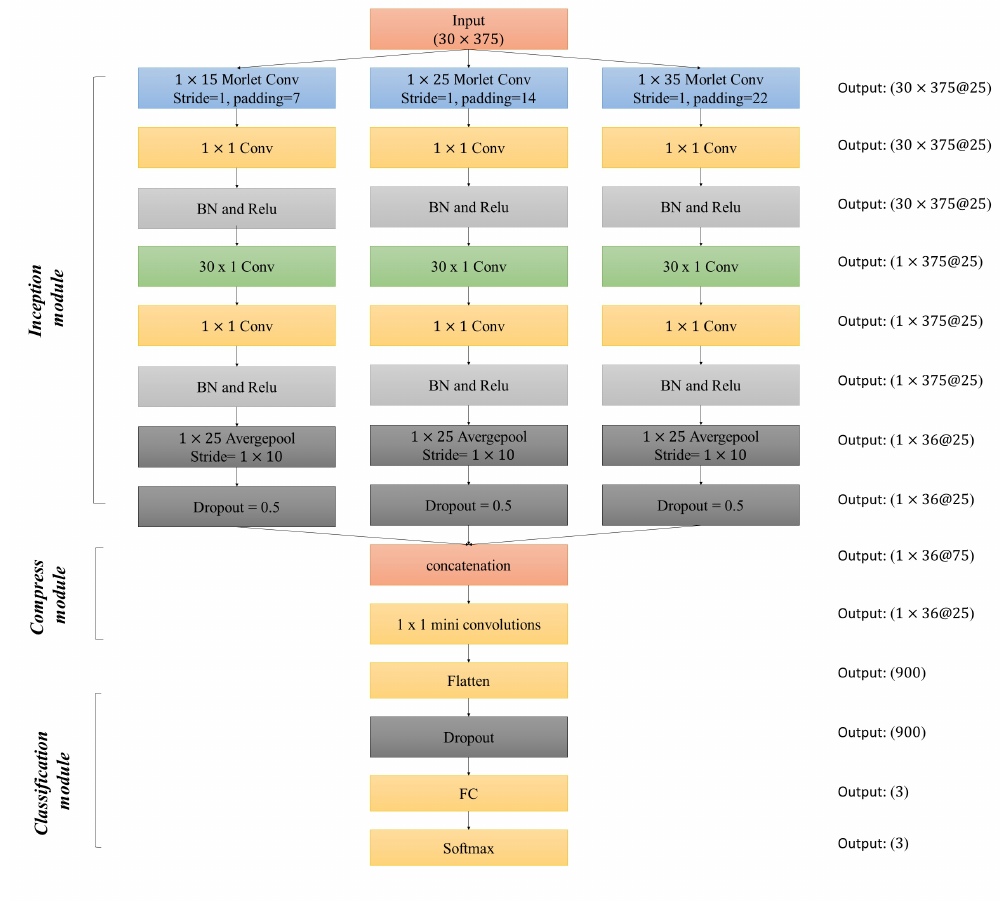
Figure 3. Architecture of